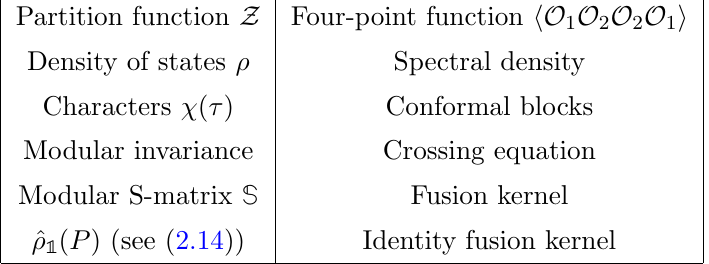
Table 1 . The analysis of partition functions and modular invariance is closely parallel to four-point functions and